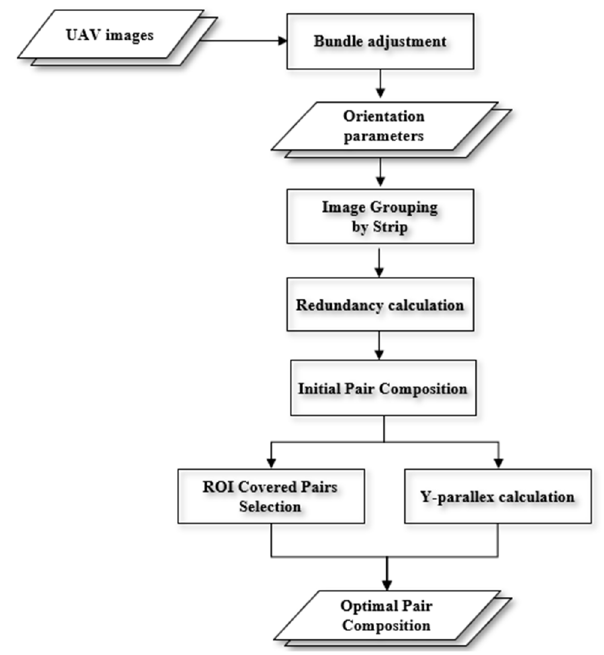
Figure 1. Overall flow chart of optimal pair selection.